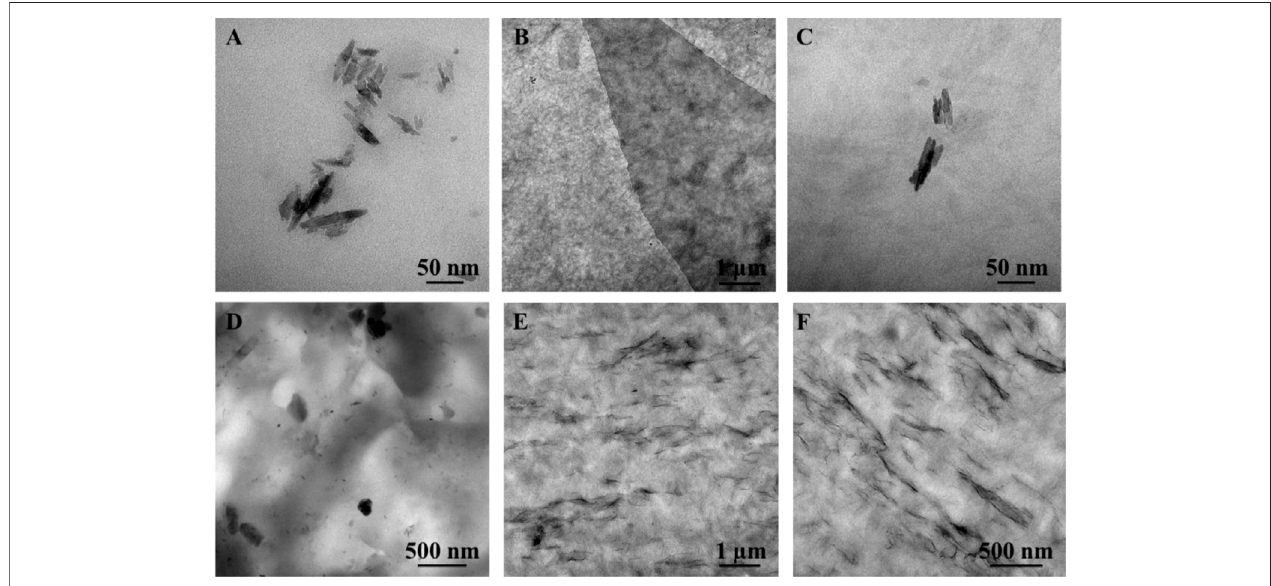
FIGURE4| Transmissionelectronmicroscopeimagesof (A) CNCs, (B,C) GO/CNCs fi lmatdifferentmagni fi cations, (D) CS/B/1C,and (E,F) CS/B/1G/1Cchitosan composite fi lms.